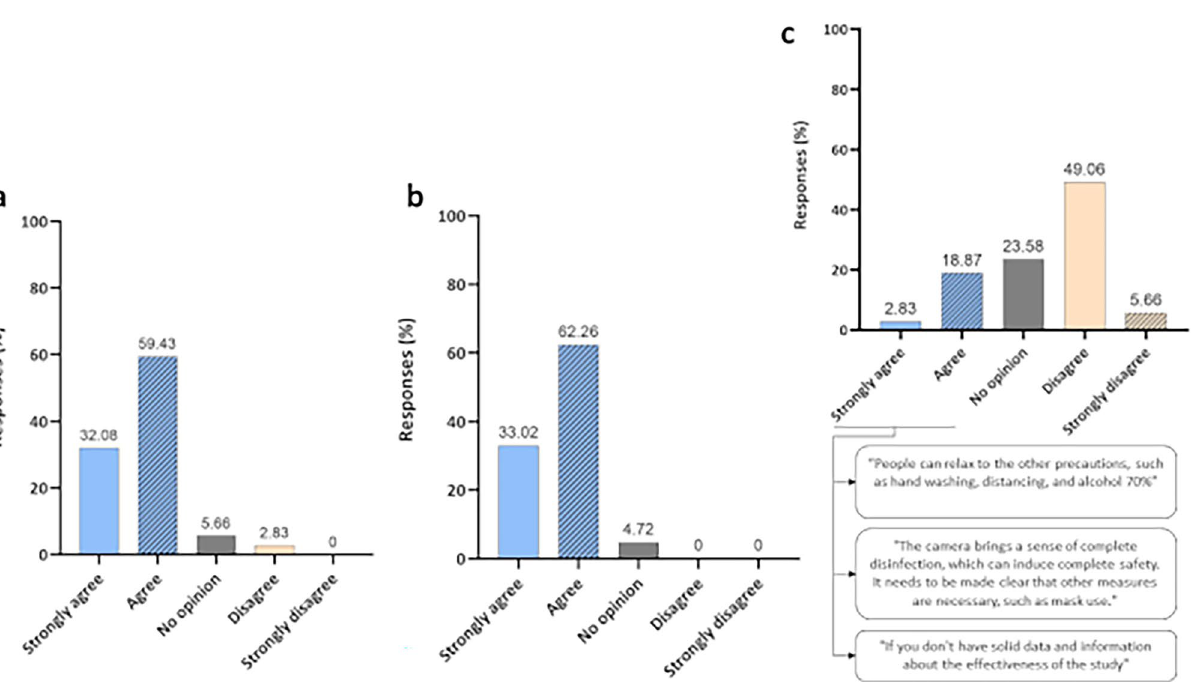
Figure 8. Participants’ opinions. ( a ) After using the disinfection chamber, the surfaces were moistened; ( b ) the disinfection chamber acts as an additional barrier to the protection of workers in general; and ( c ) use of the disinfection chamber can lead to a false sense of